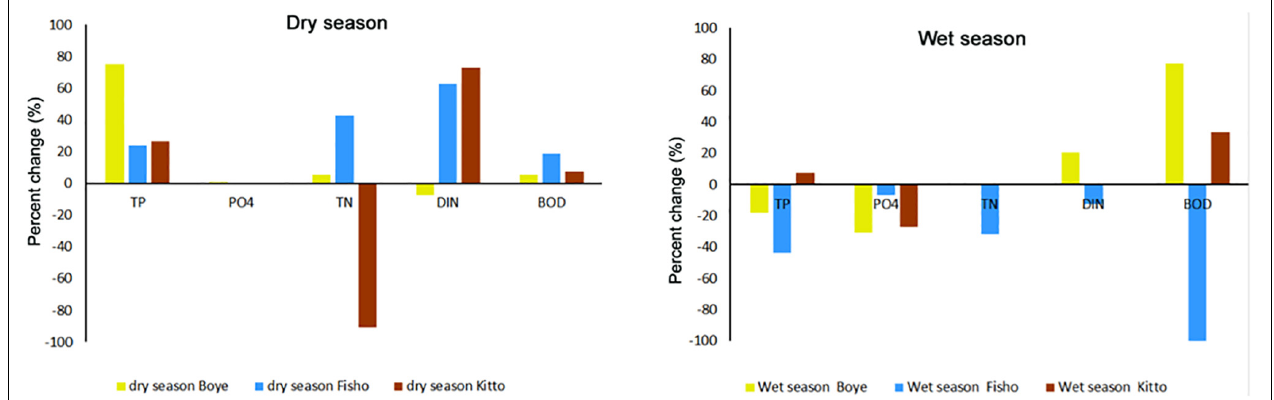
FIGURE 2 | Percent change of nutrients and BOD by natural riverine wetlands of southwest Ethiopia (Namely; Boye, Fisho, and Kitto wetlands) during dry and wet season. TP, total phosphorus; PO 4 , orthophosphate; TN, total nitrogen; DIN, dissolved inorganic nitrogen; BOD, biochemical oxygen demand (see Supplementary Table S9 for measured parameters for each site during both the dry and wet seasons).